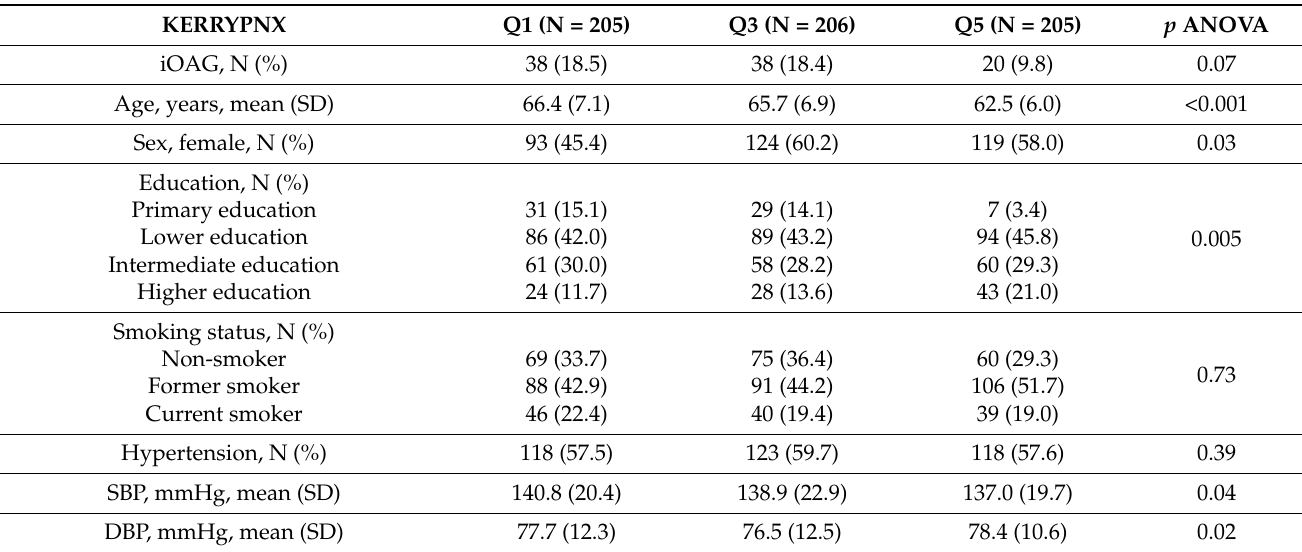
Table 2. Baseline characteristics of participants by energy adjusted total dietary nitrate intake (1st, 3rd, and 5th